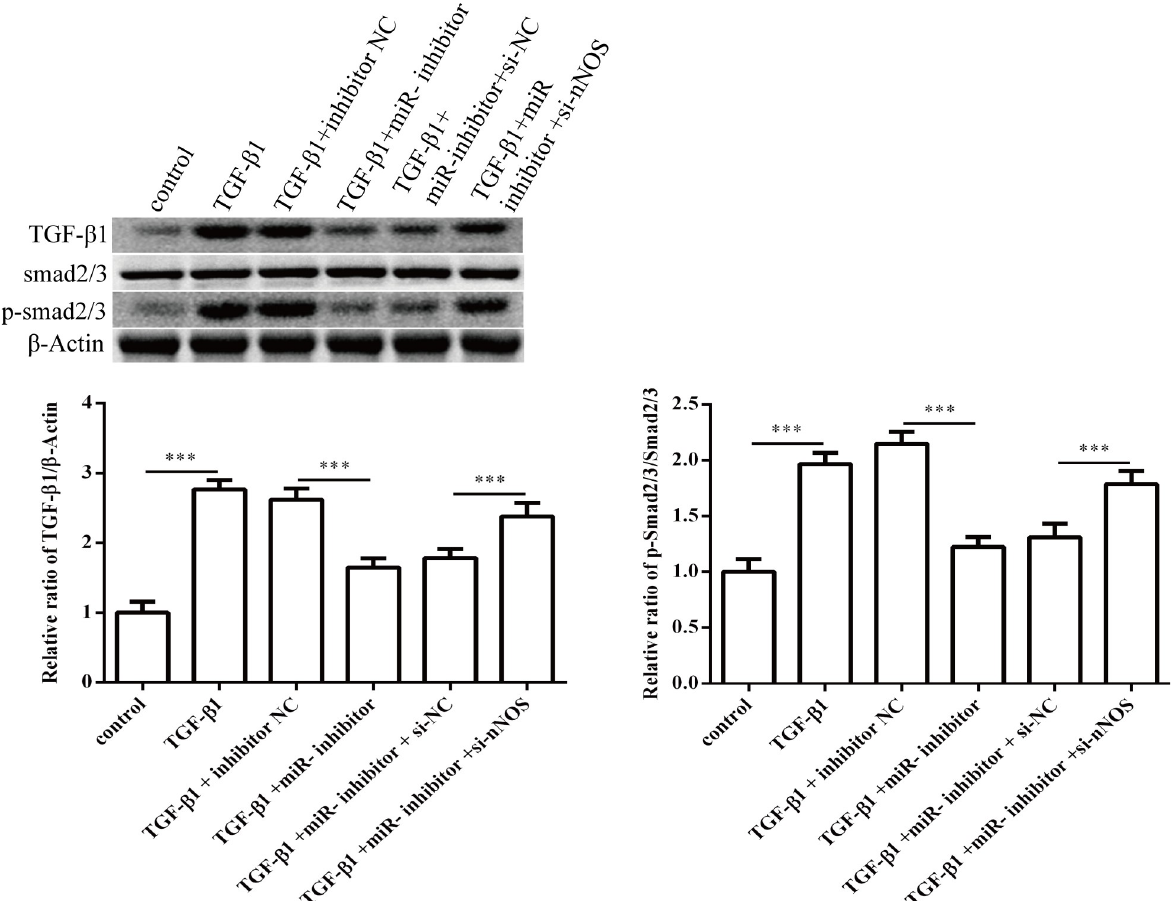
Fig 10. Effect of miR-1202 and nNOS co-transfection on the TGF- β 1/Smad2/3 pathway. All of the data are expressed as the mean ± SD. Compared with the control group. n = 3, � P < 0.05; �� P < 0.01; ��� P < 0.001. The analysis is not able to detect small significant differences due to small sample